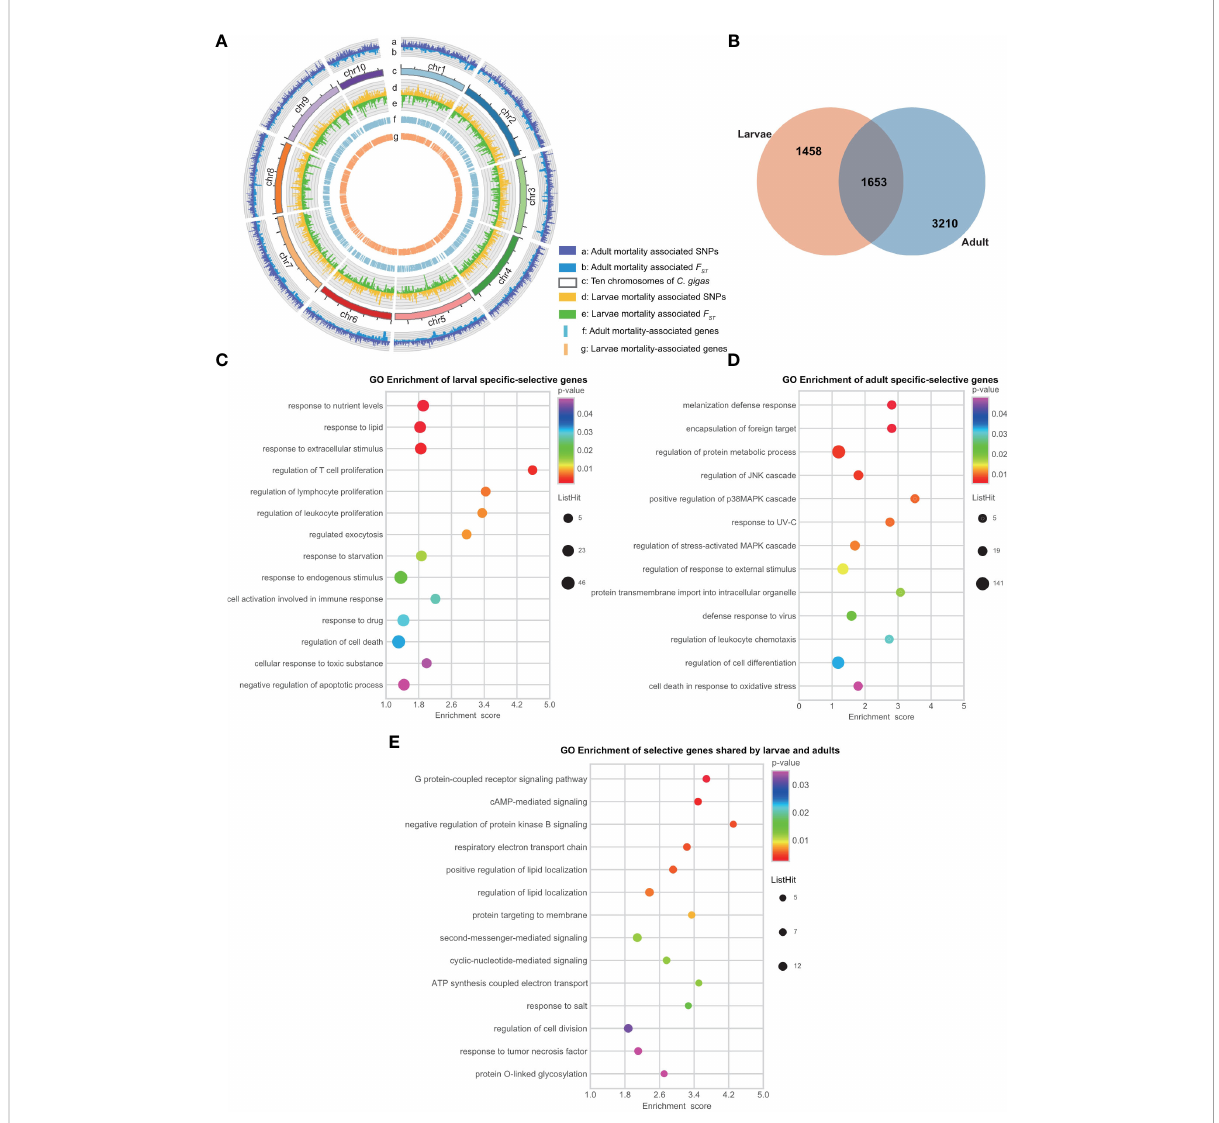
FIGURE 3 Comparative analysis of genomic loci and genes associated with larval and adult disease resistance. (A) Circos analysis of mortality associated genomic loci and regions. The allele frequency of the locus is proportional to the column height. From outside to inside (named a-g): the a and b layers represent the mortality associated SNP loci and F ST regions of the adult population; the c layer represents ten chromosomes of the oyster genome; the d and e layers represent the mortality associated SNP loci and F ST regions of the larval population; the f and g layers represent mortality associated genes in the adult and larval populations. (B) Venn diagram showed the difference of disease selected gene sets between larvae and adults based on base frequency and F ST analyses. (C – E) Gene Ontology (GO) enrichment analyses of 1,458 larvae speci fi c, 3,210 adult speci fi c, and 1,653 larva-adult shared selective